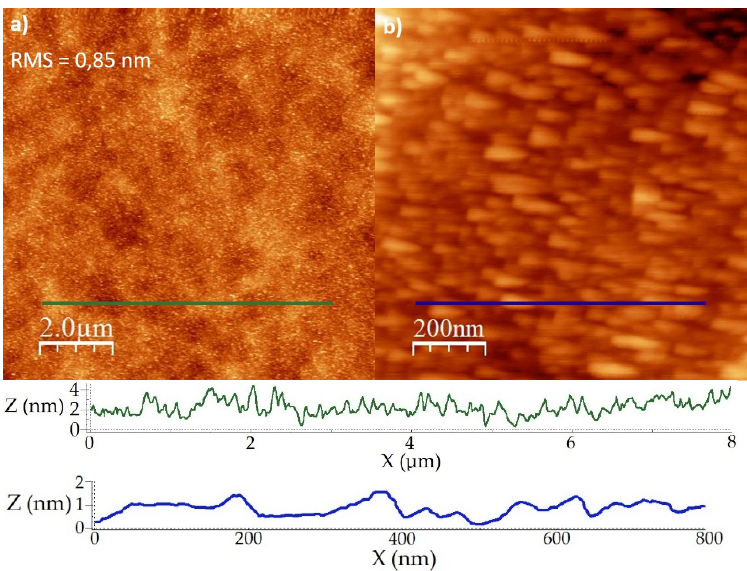
Figure 5. 10 µm  10 µm ( a ) and 1 µm  1 µm ( b ) AFM image of the GaP/Si sample. The green and Figure 5. 10 µ m × 10 µ m ( a ) and 1 µ m × 1 µ m ( b ) AFM image of the GaP/Si sample. The green and blue lines show the profiles in both scans. blue lines show the profiles in both